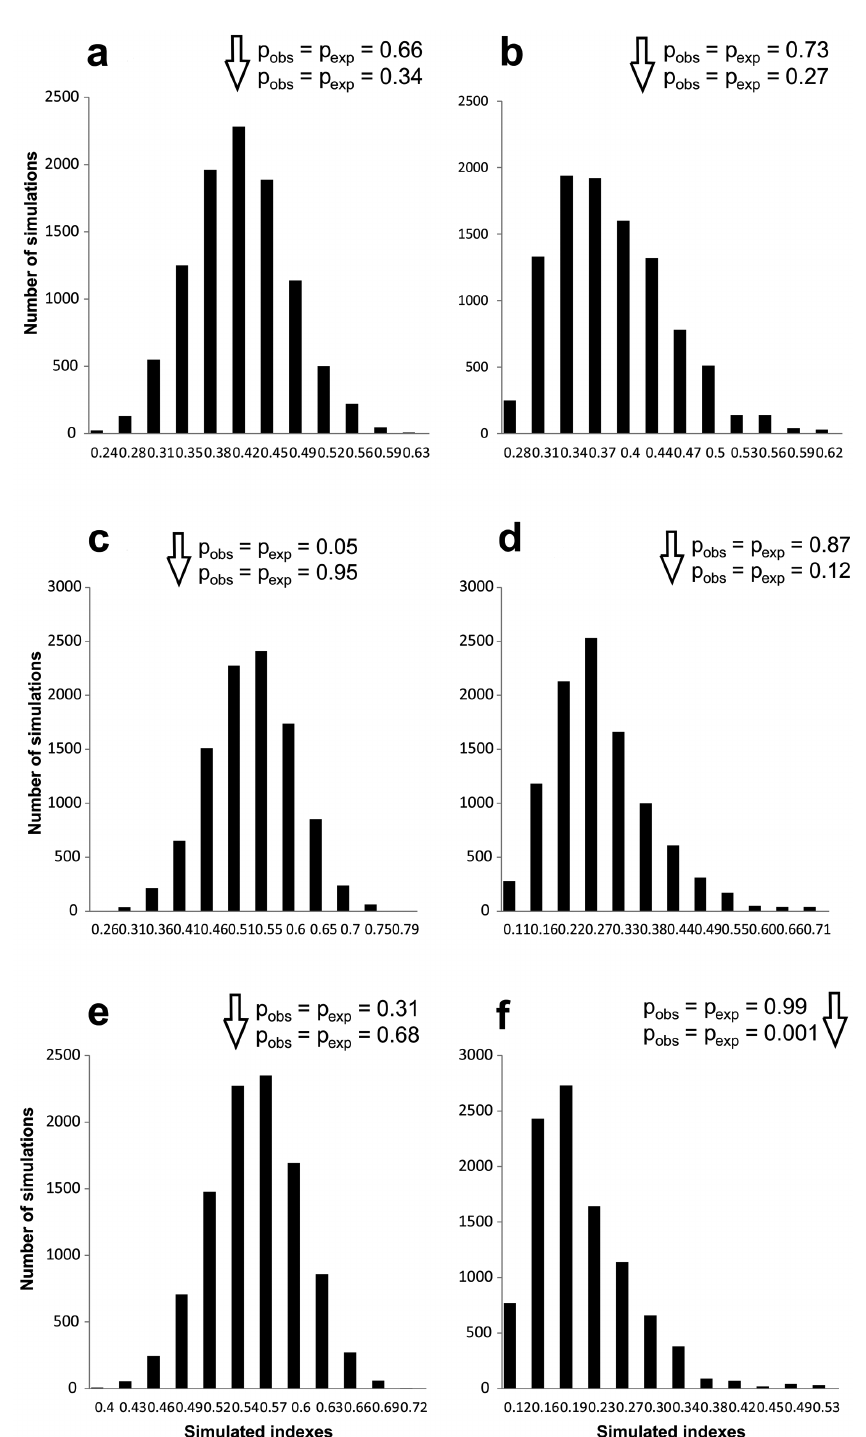
Figure 2 - Simulated pseudocommunities for niche overlap of a lizard community from a sand dune habitat, Rio de Janeiro state, Brazil. Arrows indicate the observed mean index for the = probability for observed mean; P = probability for expected mean. analyzed species. P obs exp Left column comprises simulations performed through RA2 algorithm, whereas right column using RA3 algorithm. a, b = temporal axis; c, d = spatial axis; e, f = trophic